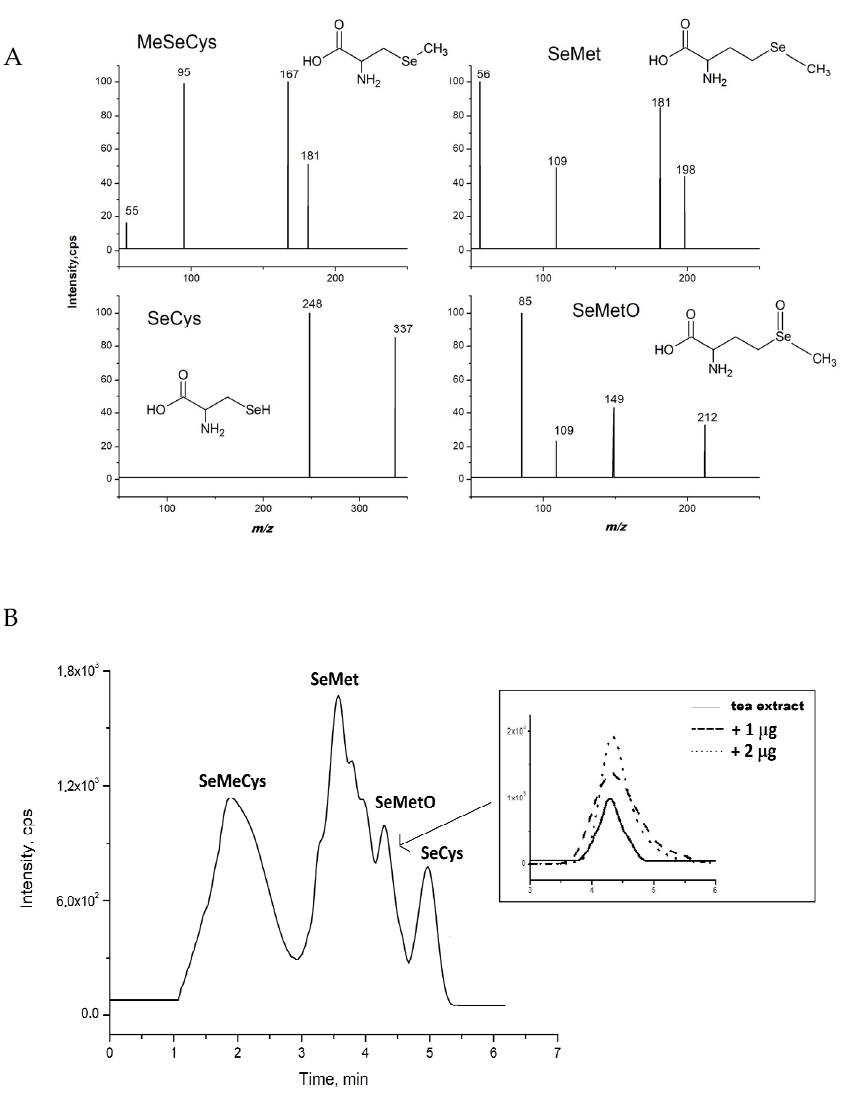
Figure 1. ( A ) The product ion spectra of organic selenium species present in water extract of Lung-Ching tea; ( B ) Chromatogram of green tea water extract (sample Lung-Ching). Atlantis HILIC column, eluent: methanol and water, (85/15, v / v ). Inset SeMetO peaks after addition of its standard solutions.